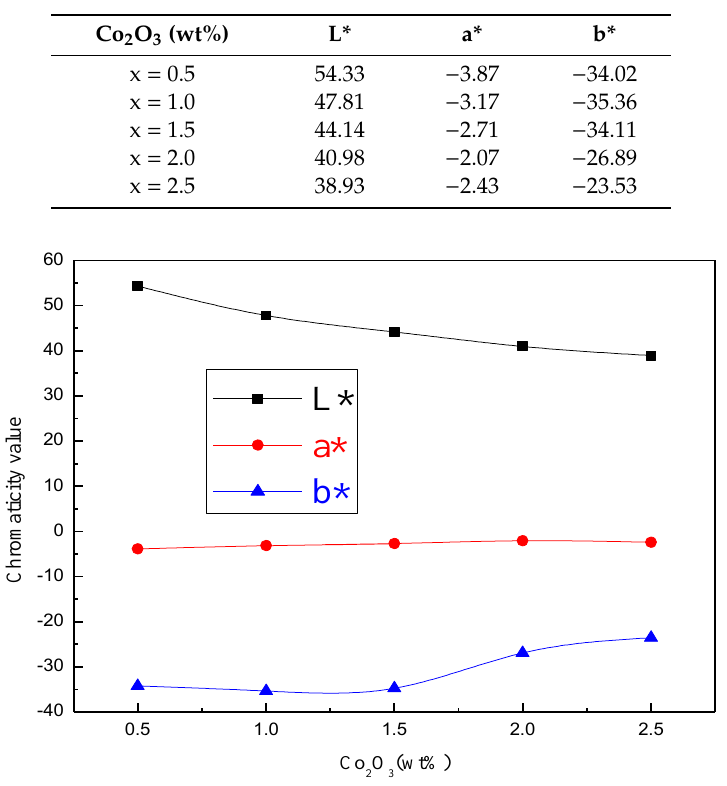
Table 2. Chromaticity changes of Mg-based lanthanum hexaaluminate with different cobalt contents.